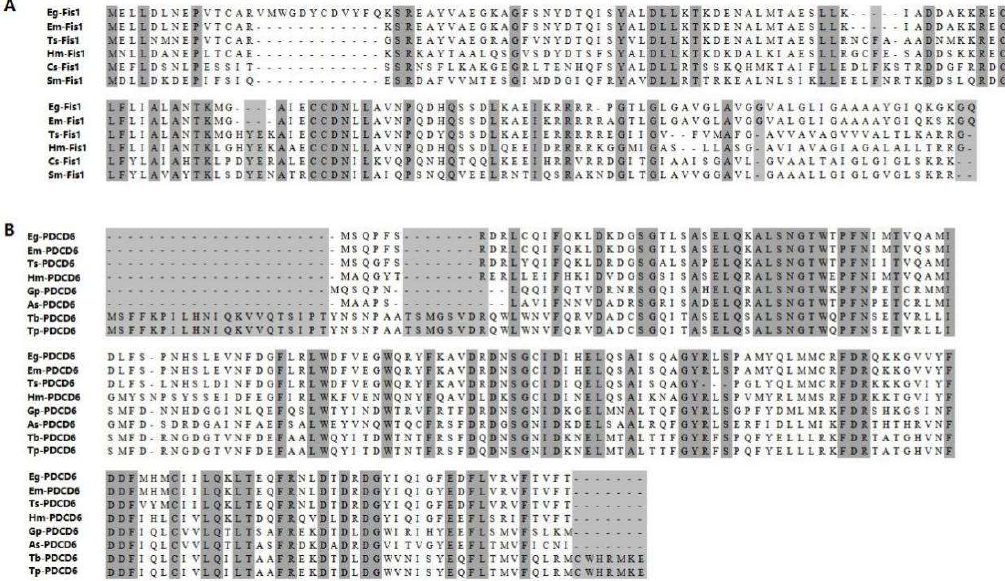
Figure 1. Sequence alignments of Eg-Fis1 and Eg-PDCD6 with homologs from other species. ( A )